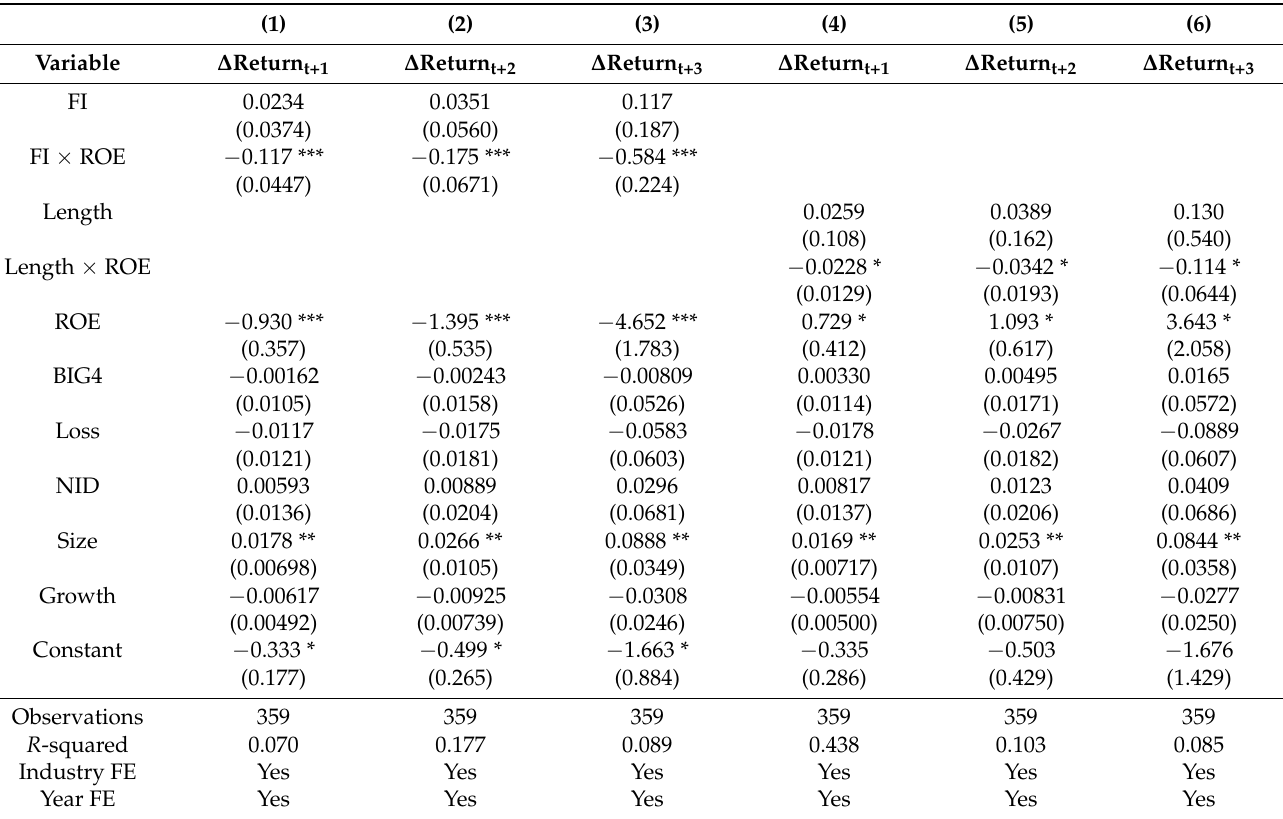
Table 4. Readability and future